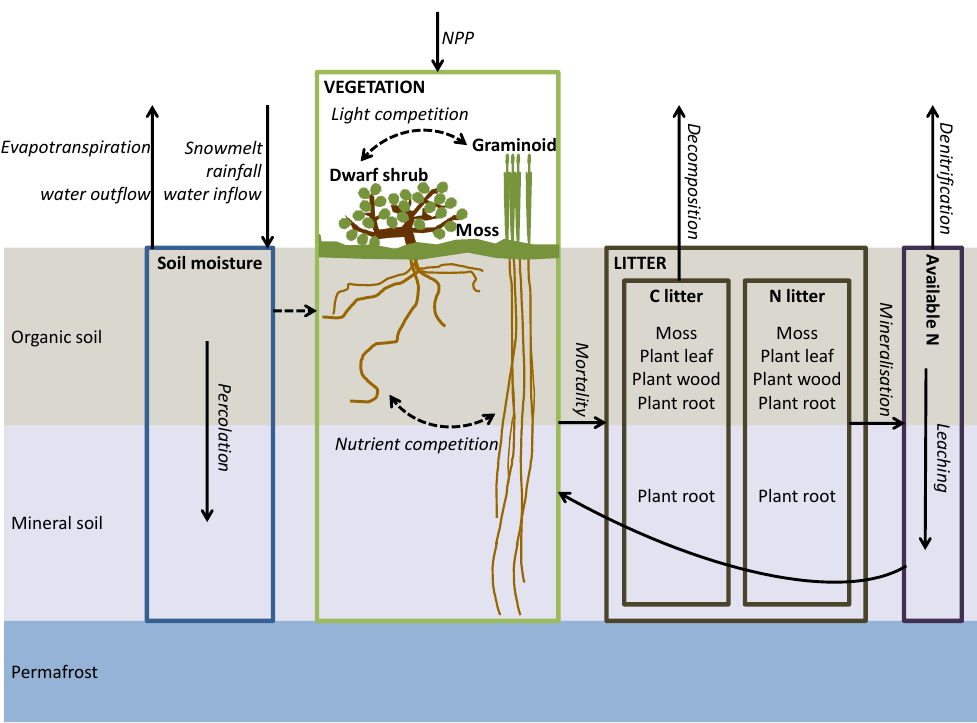
Figure 1. Schematic presentation of NUCOM-tundra, including the main processes simulated in organic and mineral soil layers and the effects of moisture and available nitrogen on vegetation. Air temperature influences many of these processes, including active layer depth, plant growth, evapotranspiration, snowmelt, decomposition, mineralisation and denitrification. The mineral soil is divided into 10 layers, each 10cm in height.